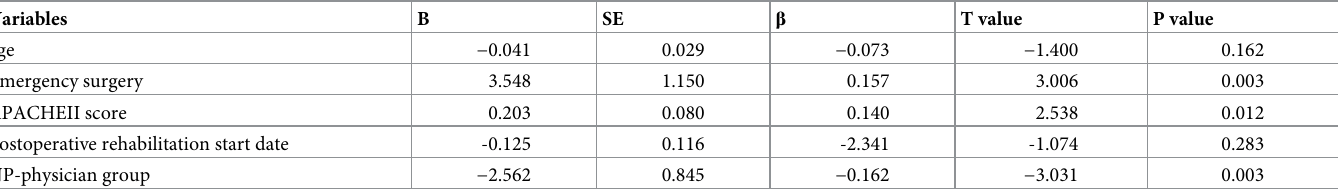
Table 3. Multiple regression analysis for ICU length of